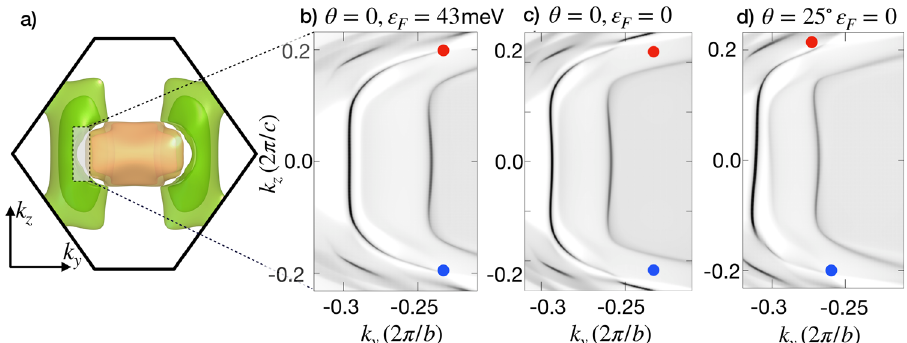
Fig. 5 Fermi arcs. a Bulk Fermi surface of NdRhC 2 . b Fermi surface of the RhC 2 -terminated (100)-surface without canting of the magnetization, fi xing the Fermi energy at the Weyl node energy ( ε Same as c for a canting angle θ = 25°.